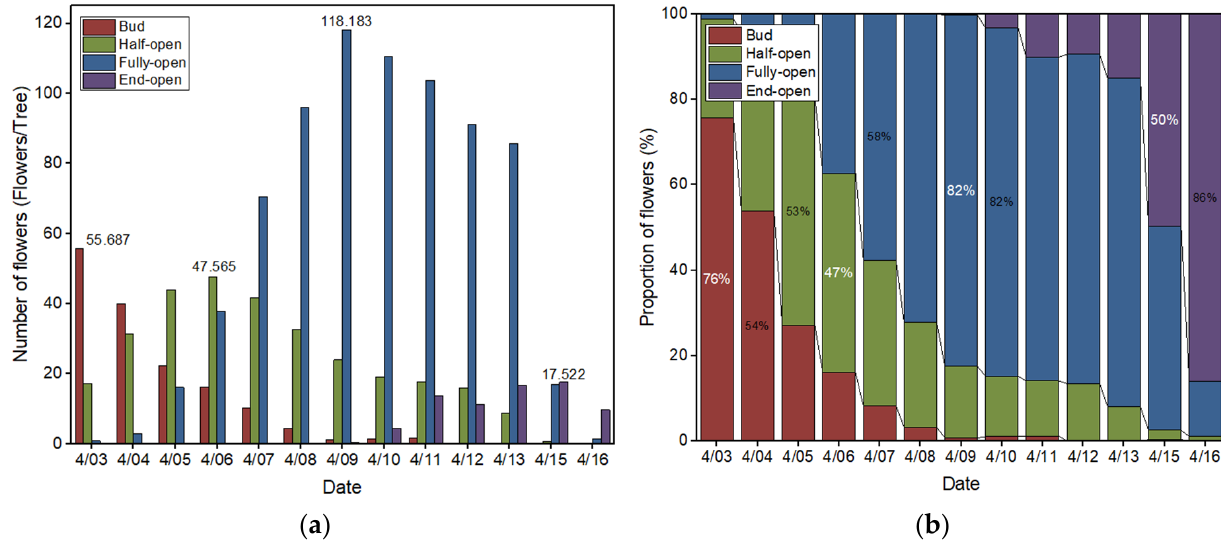
Figure 7. Flowering stage changes. ( a ) Changes in the daily number of flowers at each stage; ( b ) changes in the daily percentage of flowers at each stage.